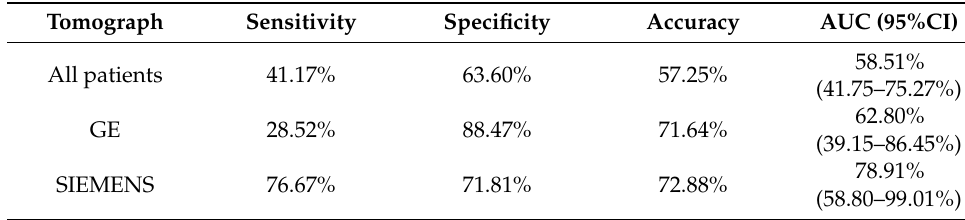
Table 4. Performance values of the predictive model for Fixed ROI.